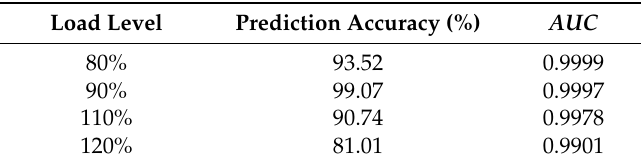
Table 6. Results of the prediction effect for an unknown load